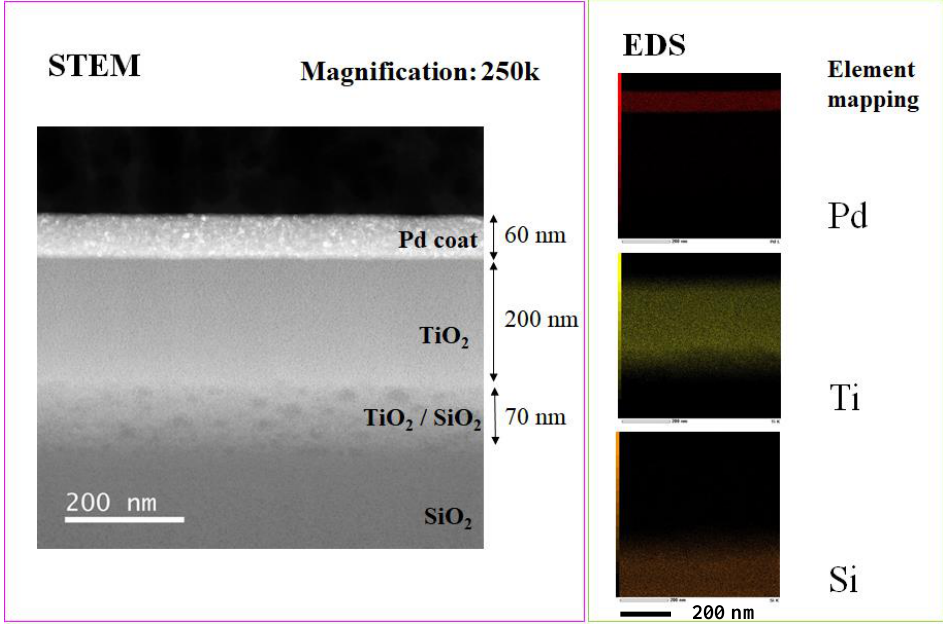
Figure 5. STEM and EDS analysis result of Pd/TiO 2 film coated on netlike glass disc.